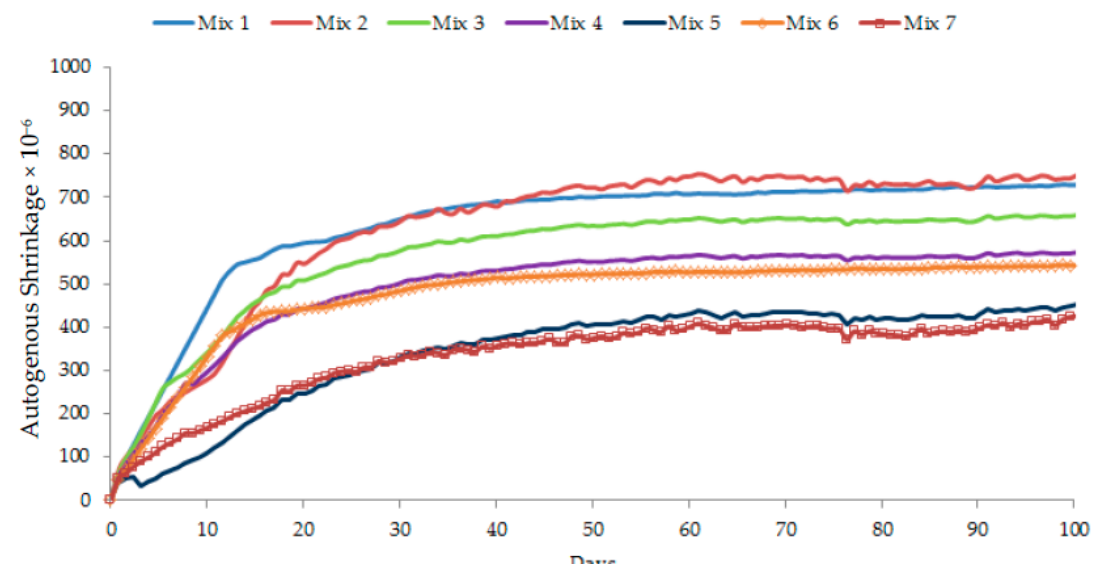
Figure 13. Time-dependent autogenous shrinkage of different concretes.